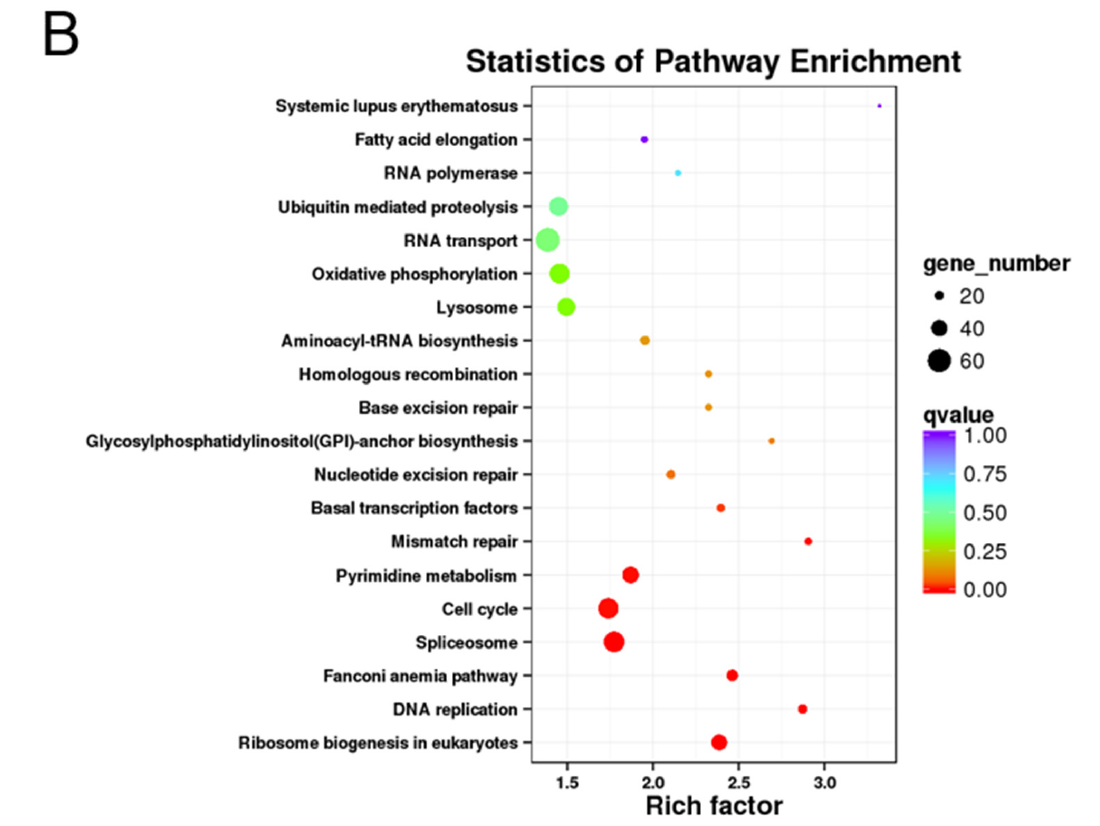
Figure 4. Significantly enriched KEGG pathways of DEGs. ( A ) Pathway enrichment analysis of DEGs upregulated in testes. ( B ) Pathway enrichment analysis of DEGs upregulated in ovaries. The pathways and rich factor are shown in the vertical and the horizontal axis, respectively. The size of the point indicates the number of genes, and the color indicates the q value.